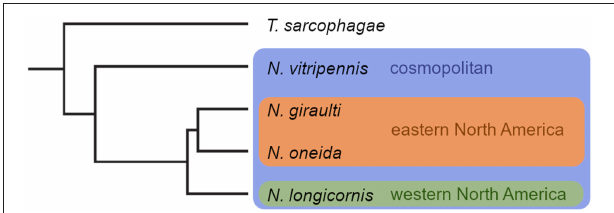
FIGURE 1 | Phylogenetic relationships and distribution of the four Nasonia species. N. vitripennis is cosmopolitan and occurs in sympatry with all other Nasonia species. N. longicornis is allopatric to N. giraulti and N. oneida . Phylogenetic tree originally published in Niehuis et al.